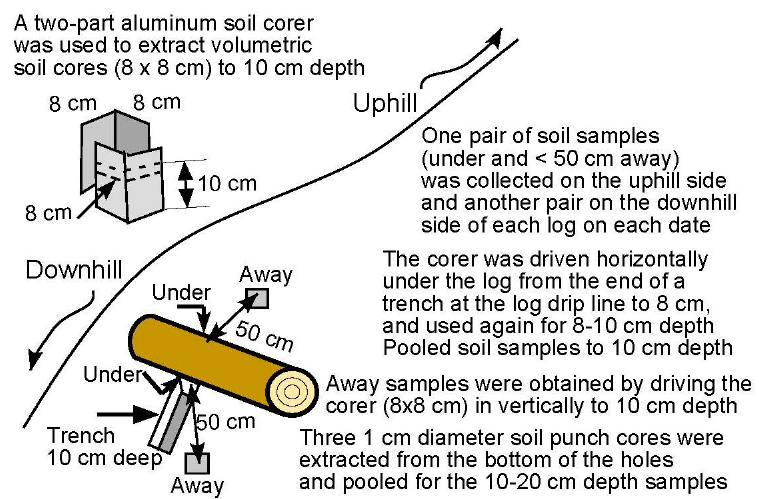
Figure 2. A rectangular, 2 ‐ part soil corer was driven into the soil horizontally from the end of an approach trench to obtain volumetric soil samples from 0 to 10 cm depth under logs. Corer halves were used twice (0–8 and 8–10 cm) to obtain soil to 10 cm depth. Paired samples taken away from the logs were extracted vertically and located 20–50 cm away from the under ‐ log core. Two pairs of cores were extracted on each date, one pair on the uphill side and the other on the downhill side of the log. Paired sample locations were randomly selected on each side of the log except for avoiding previously cored areas and large rocks. Soil samples from the 10–20 cm depth were extracted from the bottom of the first core holes using a punch corer.